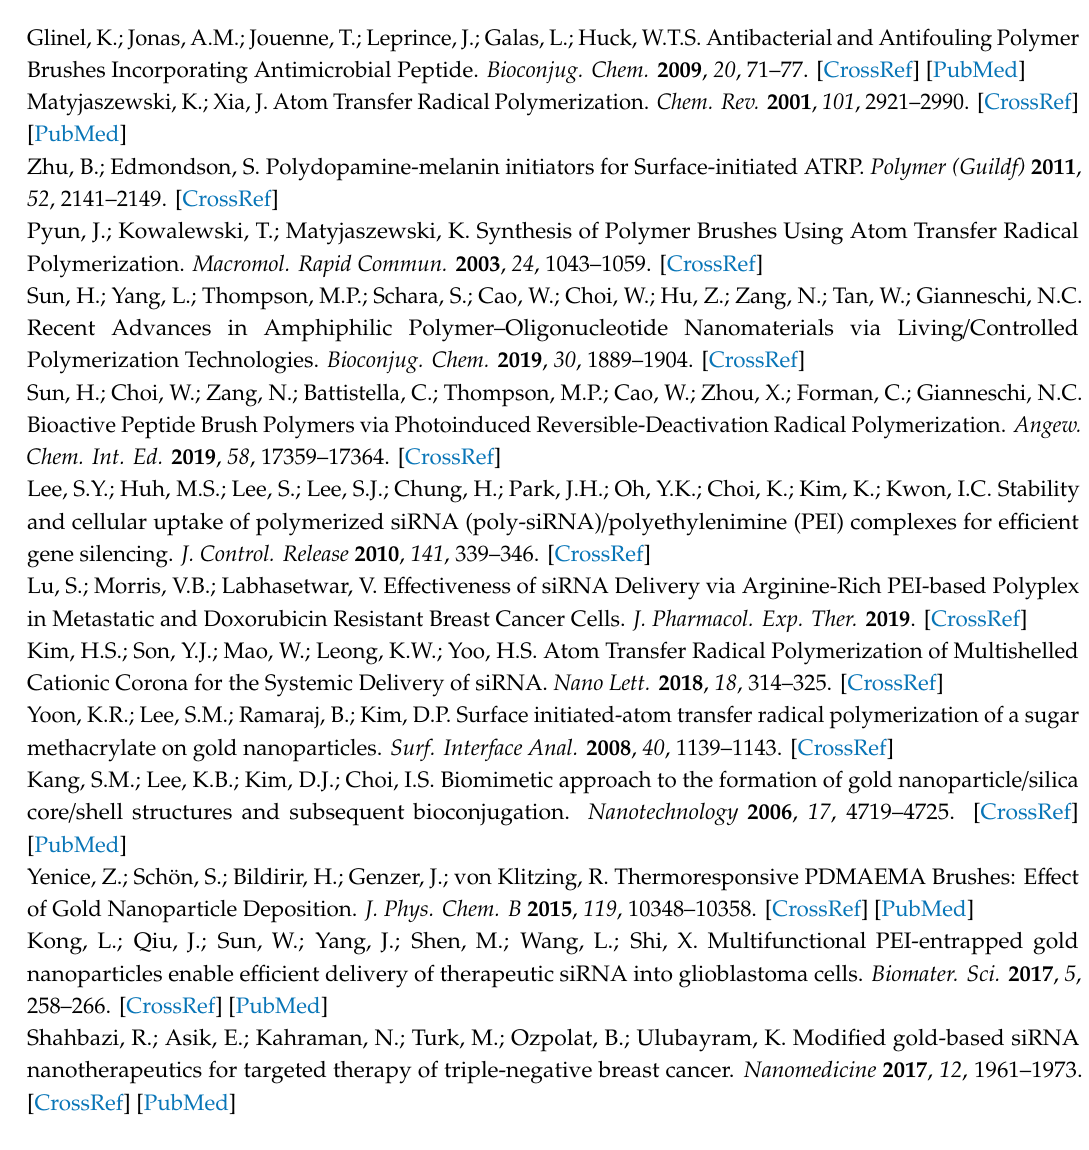
Figure S1: Incorporated PEI on SEMA@AuNP or AuNP. AuNPs was incubated in PBS at 37 ◦ C. The supernatant was collected and fluorescently labeled PEI was quantified by fluorescence spectroscopy, Figure S2: Cytotoxicities of AuNPs with or without siRNA by using MTT assay to A549 cell line. Cytotoxicities were measured by absorbance value with normalized to no treatment. PEI incorporated gold nanoparticles were conjugated with 2.5 µ g siRNA, Figure S3. Cell cycles determined by flow cytometry with PI staining. All cycles (sub G1, G0–G1, S, G2–M) were expressed by stacking their